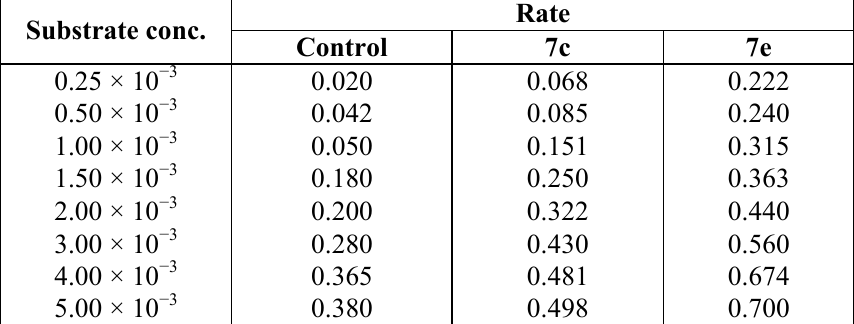
Table 1. Effect of substrate concentration on the rate of MAO-B catalyzed reactions in presence of the examined compounds 7c and 7e , compared to